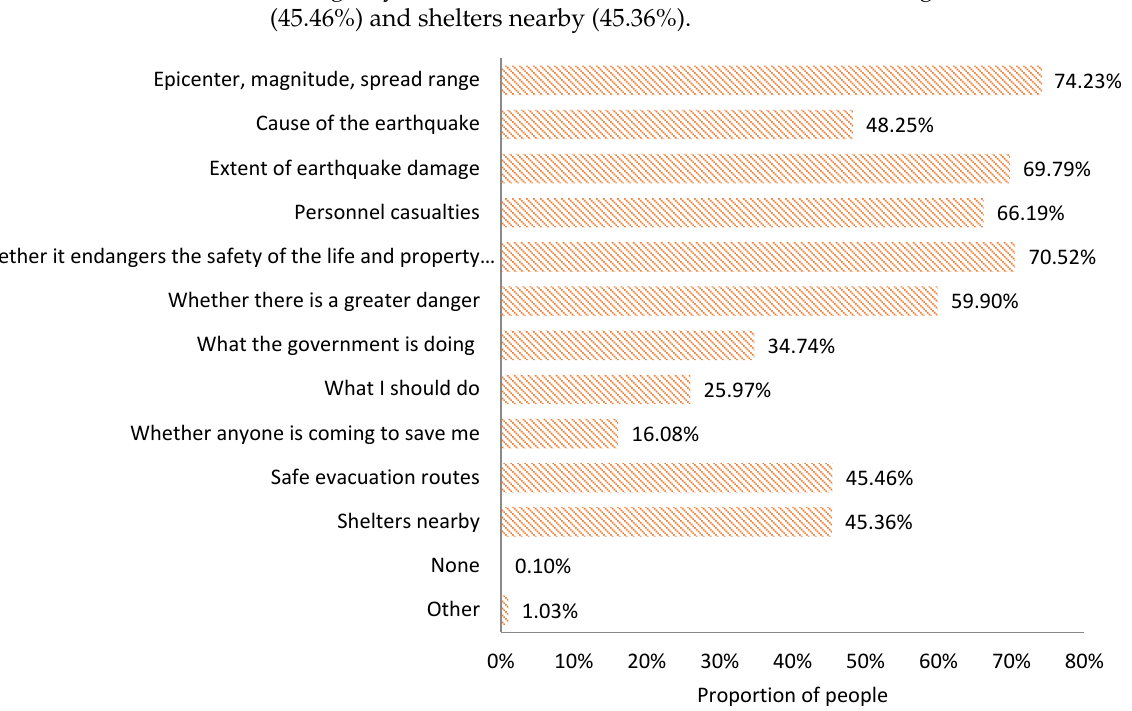
Figure 4. Information expected to be acquired by the public in the acute stage of an earthquake disaster.